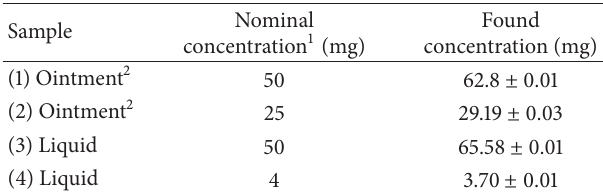
Table 3: Lidocaine quantification in the pharmaceutical formula- tions by CZE